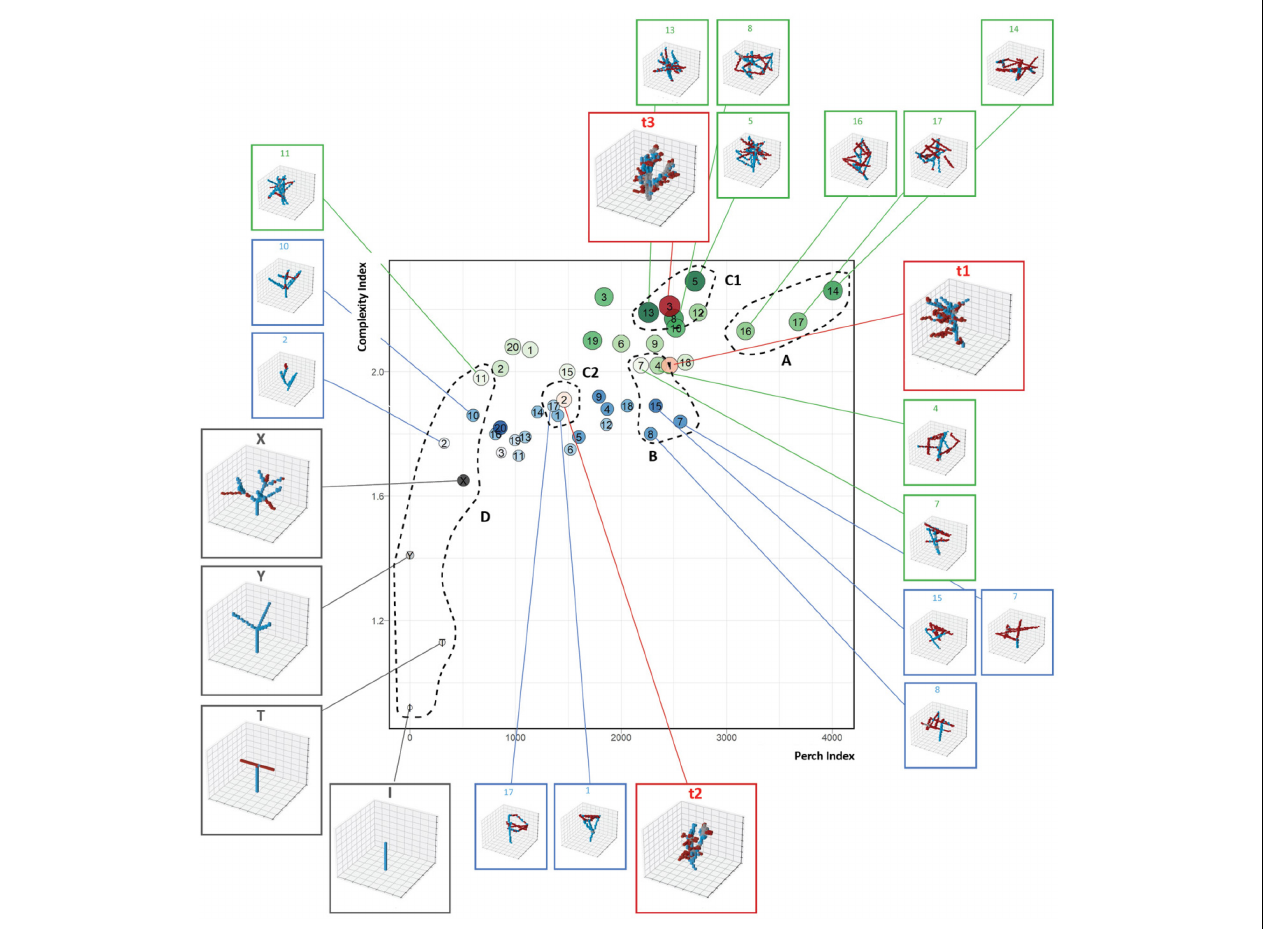
FIGURE 9 | Comparison between 3D representations of natural trees (red), human-defined simplified trees (grey), and forms synthesised by the 10-action agent (blue) and 20-action agent